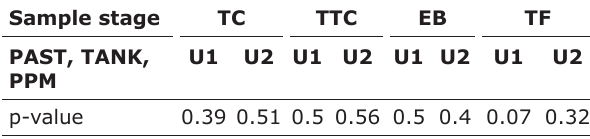
Table-3: Assessment of the indicator parameter and production line. Sample stage